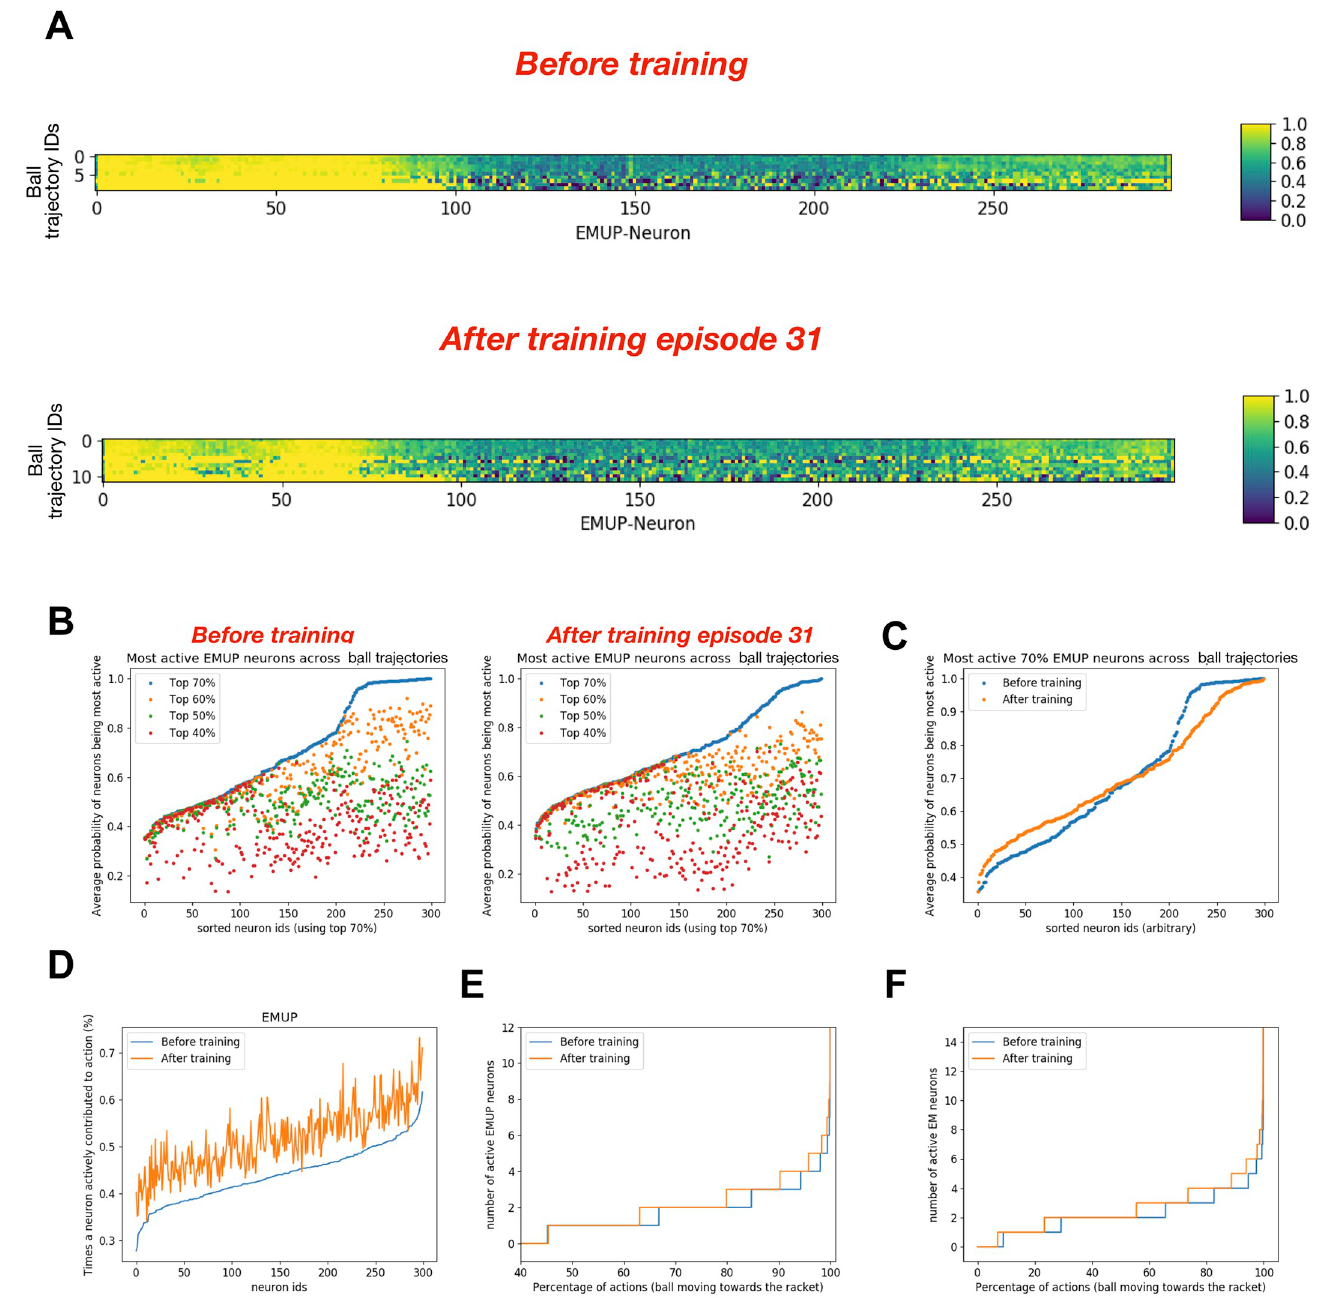
Fig 9. After training the recurrent model with sparse rewards, the dynamics of motor neurons taking part in action generation change. A) The heat maps show how often each EMUP neuron was among 70% most active neurons during repeated occurance of the same ball trajectory before training (upper heatmap) and after training episode 31 (lower heatmap). Note that the neuron ids are the same in both heatmaps but input seq ids may vary. B) The plot shows how often each EMUP neuron was among 70%, 60%, 50% and 40% most active neurons during repeated occurance of the same ball trajectory before training (left) and after training episode 31 (right). Note that the neuron ids are sorted using top 70% neuron indices. C) Comparing the average probability of each motor (EMUP) neuron being among 70% most active neurons before and after training episode31. D) The plot compares the percentage of times a motor (EMUP) neuron actively contributed to action generation. After training, the contribution of each motor (EMUP) neuron in action generation increased proportionally (with some variability) to the contribution before training. E) The plot compares how many times at least 1 EMUP neuron was involved in action generation before and after training. Before and after training, at least 1 EMUP neuron was active for 55% of actions generated. F) The plot compares how many times at least 1 motor neuron (either EMUP or EMDOWN) was involved in action generation before and after training. Before training, at least 1 motor neuron was active for 92% of actions generated. After training, at least 1 motor neuron was active for 93% of actions